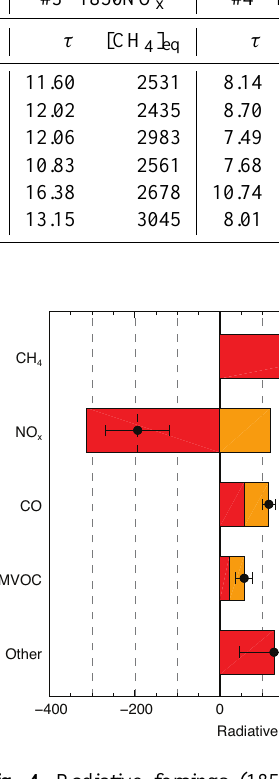
tra ozone forcing is − 96 mW m − 2 . Adding this to the ozone forcing found directly from the NO x attribution experiment (193 mW m − 2 ) yields a net ozone forcing of 97 mW m − 2 for model B (Table